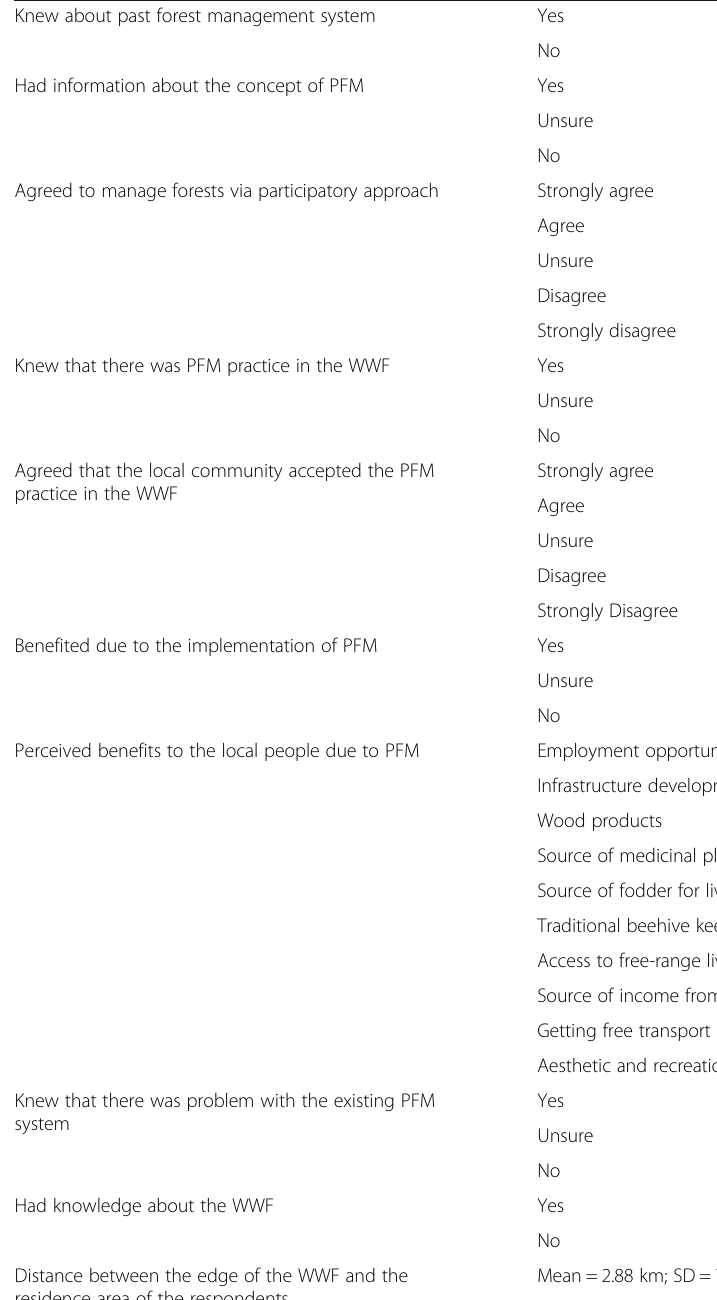
Table 2 Socio-economic characteristics and descriptive results